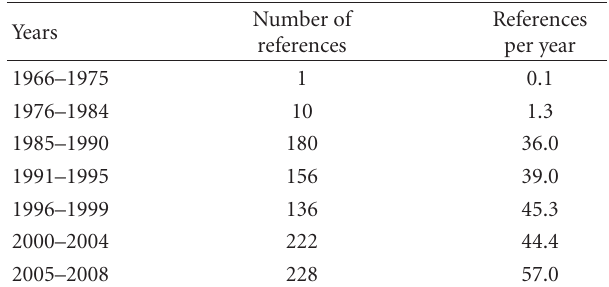
Table 2: PubMed literature search for “Tooth